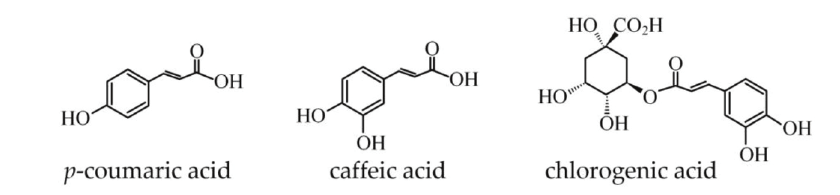
Fig. 1 – Chemical structure of phenolic